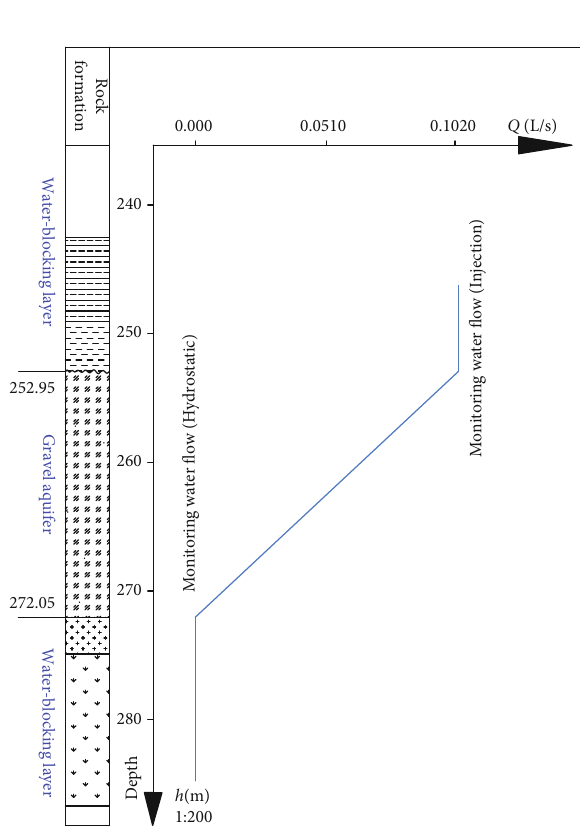
Figure 7: Flow monitoring diagram in the wind oxidation section of the auxiliary shaft.